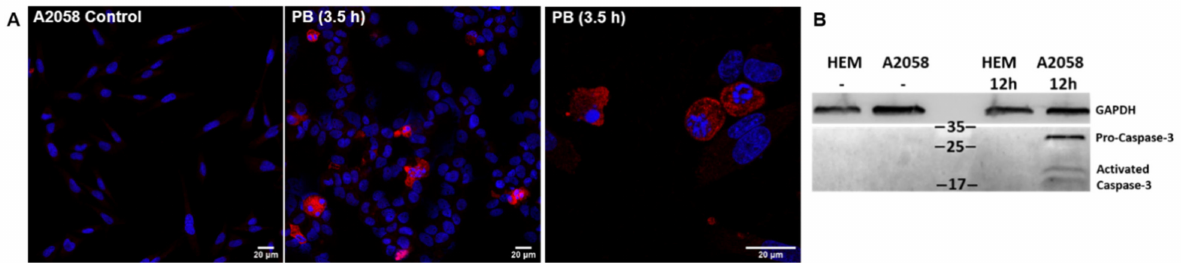
Figure 6. Detection of activated caspase-3 in A2058 cells as an indicator of apoptosis. ( A ) A2058 cells in the absence (control panel) and presence of PB (40 µ M). Samples were stained for activated caspase-3 (red) as an indicator of apoptosis and cell nuclei (blue) were detected with 4 (cid:48) ,6-diamidino-2-phenylindole. ( B ) Immunoblot of caspase-3 corresponding to human melanocytes (HEM) and A2058 cells treated 12 h with 20 µ M PB. GAPDH is used as loading